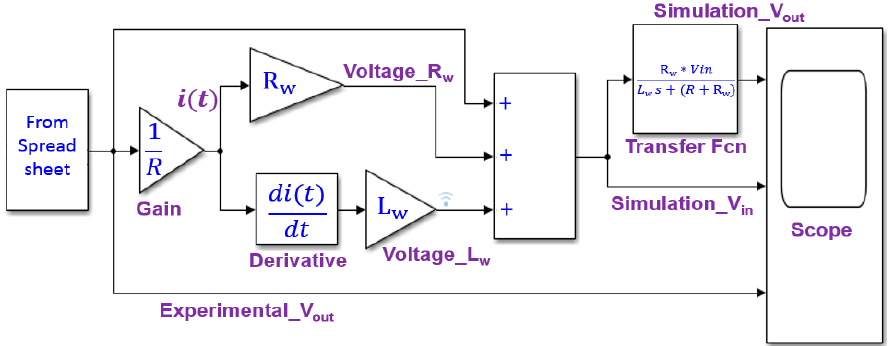
Figure 5. Block diagram for simulating the electrical circuit model of the Wiegand sensor by MATLAB/Simulink.